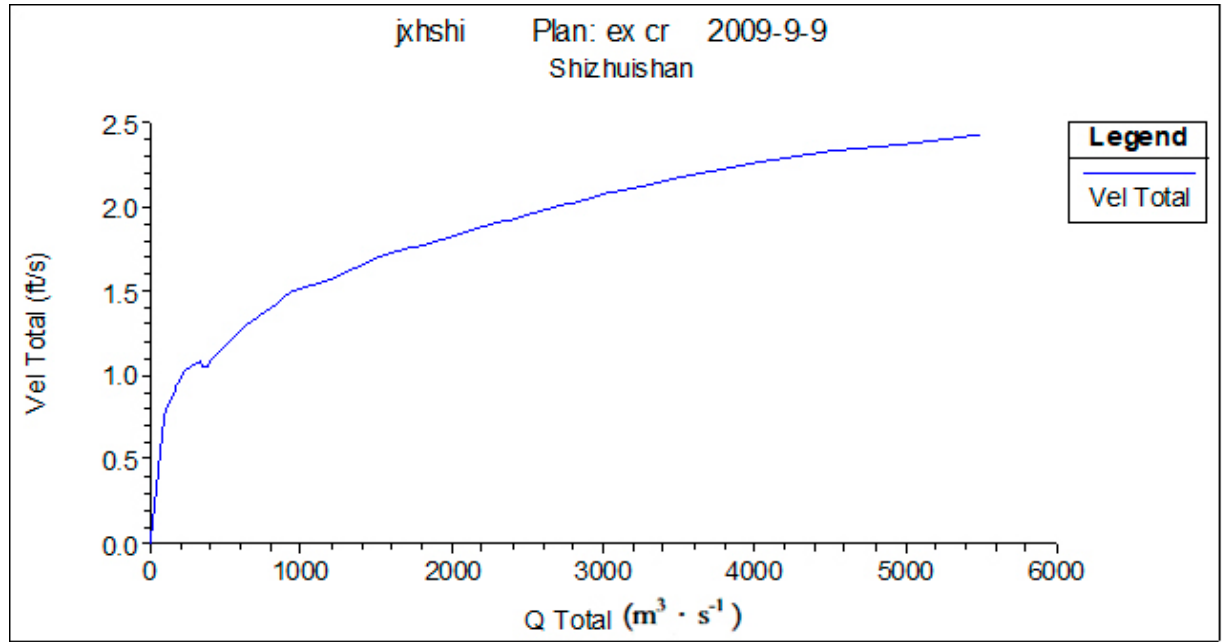
Figure 5. Change at Shizuishan cross under different flows. Source: China Water Resources Yearbook, 2018. In these figures, we can see that when the low flow is about 150 m 3 ·s − 1 from November to March, the water depth and flow rate can meet the survival necessity of Silurus lan- zhouensis . Therefore, research suggests that the low limit flow satisfying for Silurus lan- zhouensis in Shizuishan is 150 m 3 ·s − 1 . In terms of habitat conditions required for fish from April to June, when the flow is greater than 400 m 3 ·s − 1 , the wetted perimeter increases slowly, which means 400 m 3 ·s − 1 is the inflection point of wetted perimeter change, i.e., when the flow is greater than 400 m 3 ·s − 1 , the shallow area can be provided to meet the demand for fish spawning.